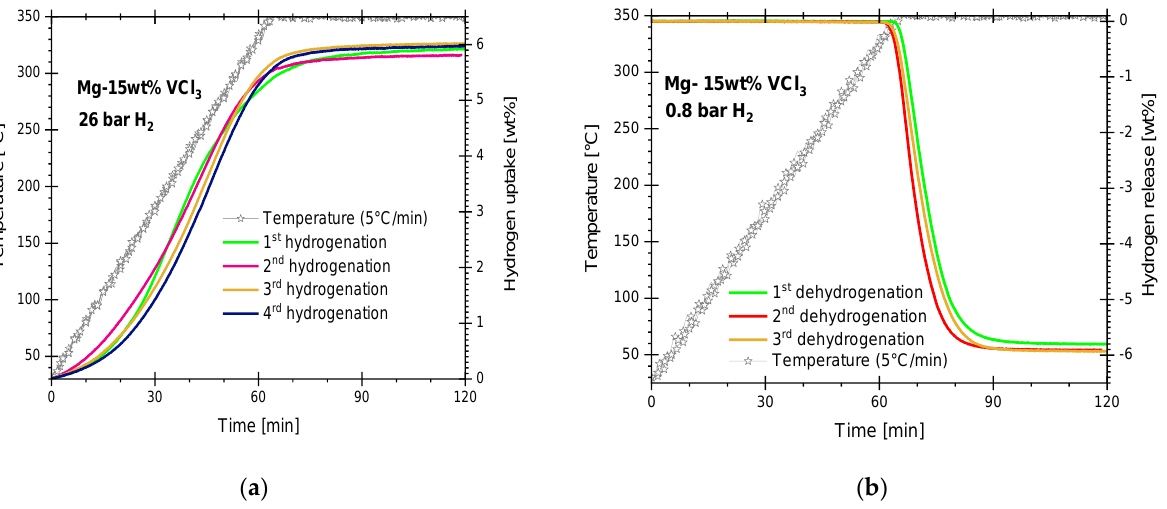
Figure 1. Hydriding/dehydriding cycles of cryogenically prepared Mg-15wt.% VCl 3 . ( a ) Hydriding at 350 ◦ C and 26 bar. ( b ) Dehydriding at 350 ◦ C and 0.8 bar. 5 ◦ C/min heating rate. Isothermal hydriding at 350 ◦ C was impossible to follow without uncertainty because of its quickness, despite that the data collection ratio was increased up to 10 data sets each second. Just a few fractions of a second after a hydrogen aliquot was introduced at 350 ◦ C, the reaction was running in full. From our experience with Mg-based hydrogen storage materials, hydrogen uptake in this cryogenically prepared Mg-VCl 3 mixture is remarkably fast. Figure 2a presents the hydriding processes performed under isothermal (50–300 ◦ C) conditions and 26 bar. For the isothermal curves, hydrogen uptake levels and kinetics improved with increasing temperature, being 5.6 wt.% hydrogen uptake after one hour at 300 ◦ C, and 1.3 wt.% after two hours at 50 ◦ C. Hydriding at 300, 250, and 200 ◦ C completed 80% of their maximum hydrogen uptake in about 1, 3, and 14 min, respectively. For the tests at 150, 100, and 50 ◦ C, the experiments were stopped after 2 h. In those conditions, the hydrogen uptake was 3.9, 3.0, and 1.3 wt.%, respectively. Hydriding kinetics were notably slower at those